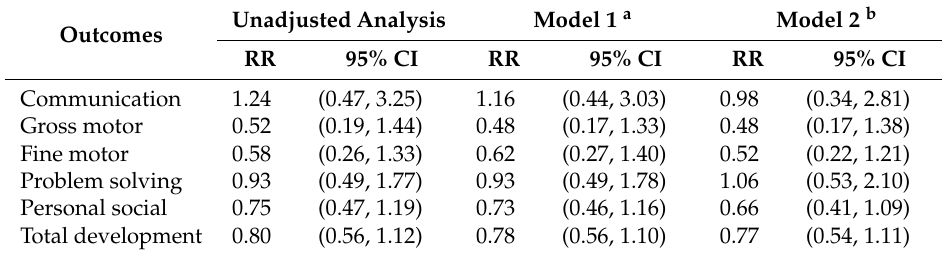
Table 6. E ff ects of maternal prenatal multi-micronutrient supplementation compared with iron–folic acid supplementation on development delay at 36 months